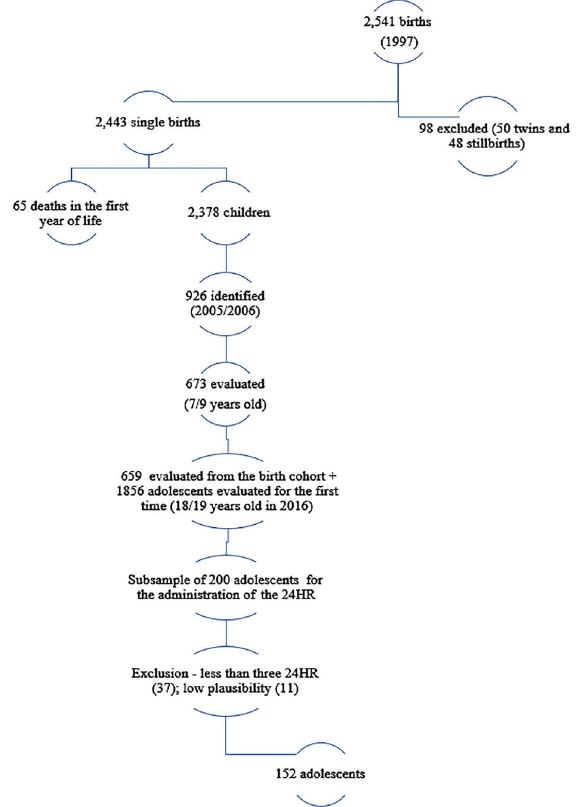
Figure 1. Sampling of the São Luís, MA cohort 1997-98/2005-06/ 2016 and the adolescents evaluated for the fi rst time (2016). 24HR: 24-h